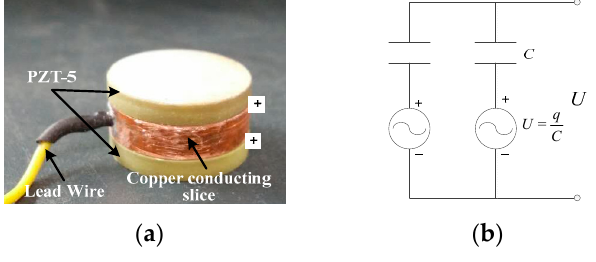
Figure 5. ( a ) The force-sensing element with two piezoelectric patches in parallel; ( b ) Its simplified equivalent circuit. Table 1. Parameters of PZT-5 piezoelectric ceramic.